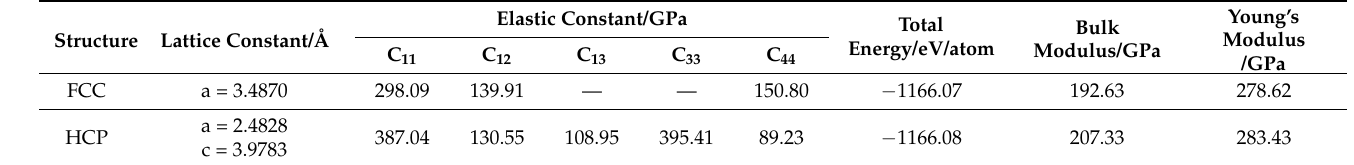
Table 2. First-principle calculations of Co 35 Cr 20 Fe 20 Mn 20 Ni 5 with FCC and HCP